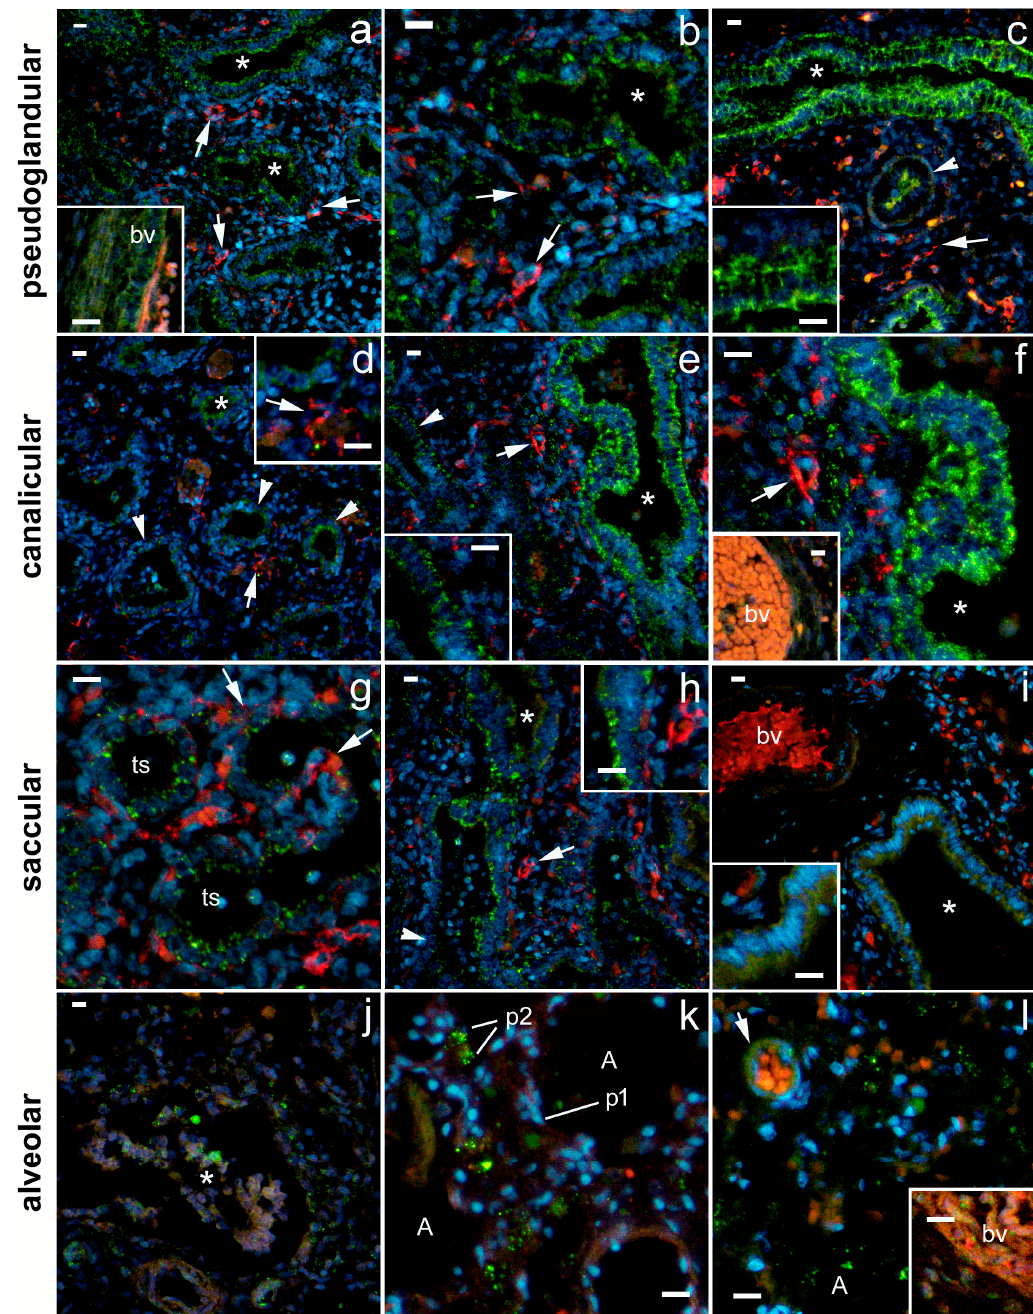
Figure 6. Immunofluorescence staining of fetal human lungs at different developmental stages: pseudoglandular ( a – c ), canalicular ( d – f ), saccular ( g – i ), and alveolar ( j – l ) with 5-HT3A and CD31/PECAM markers. Nuclear staining DNA DAPI is shown in parallel with 5-HT1A and CD31/PECAM im- munofluorescence (merge). Green staining indicates positive expression of the 5-HT3A receptor, whereas red staining indicates expression of CD31/PECAM-1, and blue staining indicates nuclear staining with 6-diamidino-2-phenylindole dihydrochloride (DAPI). Images were taken at 400 × magnification; ( a , c ) (main image), ( d ) (main image), ( e ) (main image), ( h ) (main image), ( i ) (main image), and ( j ) (downsized image). Scale bar = 20 µ m. Asterisks—proximal airways/bronchioles; arrows—blood capillaries; arrowheads—distal airways, cuboidal epithelium lining the air spaces; bv—blood vessel (mostly artery); smc—smooth muscle cells; ts—end sacs; p1—pneumocyte type I; p2—pneumocyte type II;